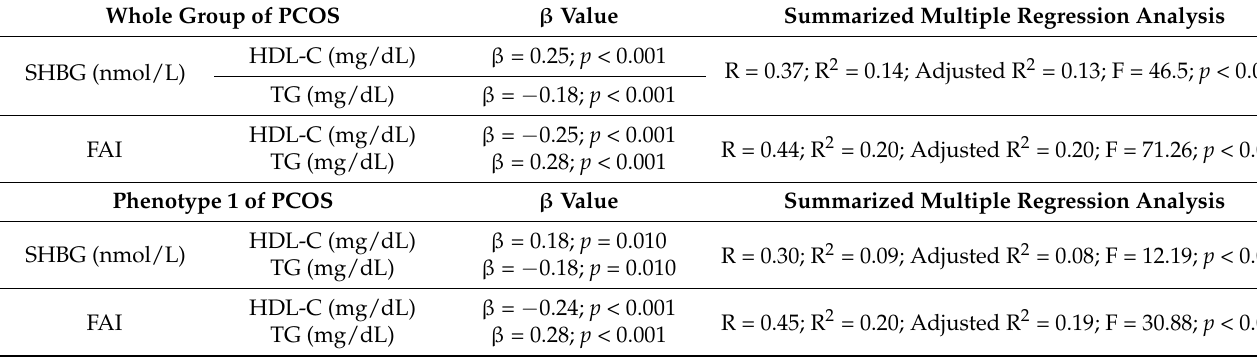
Table 5. Multiple regression analysis in the whole group of women with PCOS and in the phenotype 1. Whole Group of PCOS β